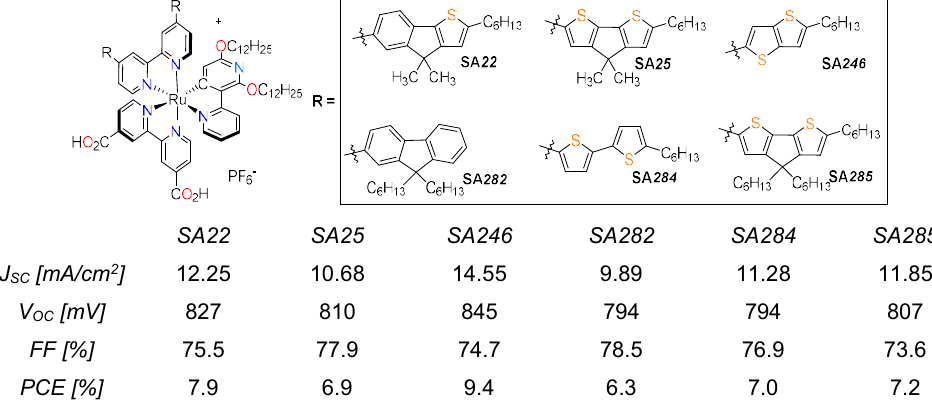
Figure 20 . Dye-loading values obtained from the desorption of dyes from sensitized titania films [114]. In the next study, we have further developed three new sensitizers SA633, SA634, and SA635, which have very similar substituents on the ancillary ligand based on diphenyl amine (Figure 21) [115]. In this work, we obtained PCEs in the range of 7.6–8.2%, with the best efficiency achieved with SA634 having phenothiazine substituents. The difference in dye-loading was negligible and the J SC matched well with the current density derived from the IPCE measurements. We related the differences in performances to the obtained V OC which we based purely on electron lifetimes obtained from charge extraction and transient photovoltage decay measurements. Additionally, in both works we have shown that although the organic substituents on the ancillary ligand improve photophysical